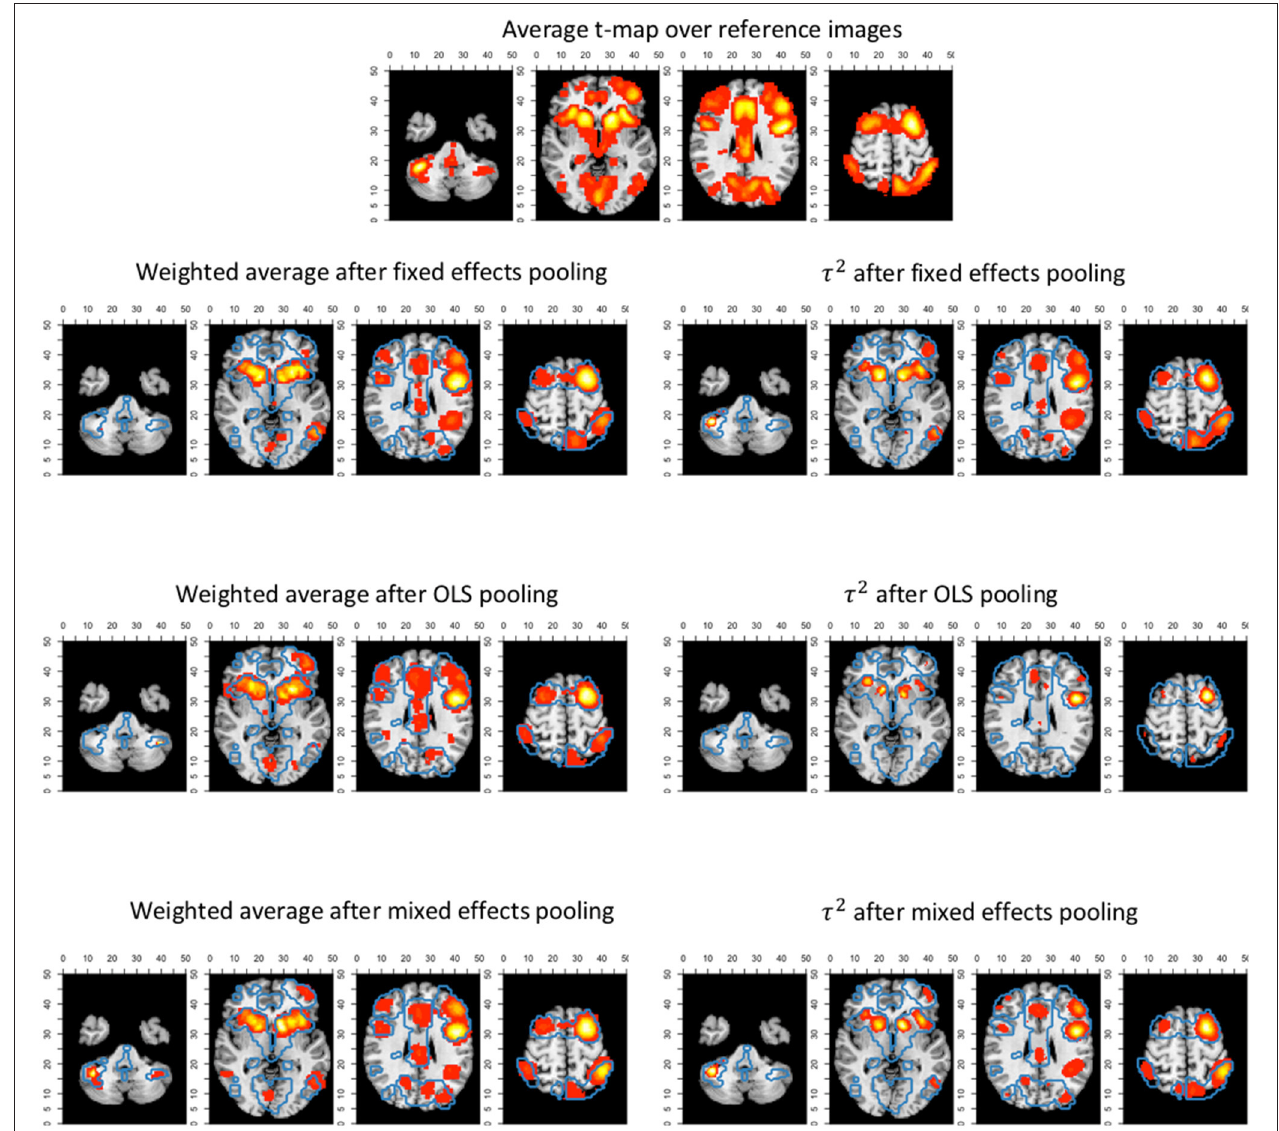
FIGURE 14 | Slices (MNI z-coordinates from left to right: studies and the weighted average of the random effects meta-analysis (statistically significant voxels only) using the 3 pooling models for K represent the average t-map of the reference images shown as